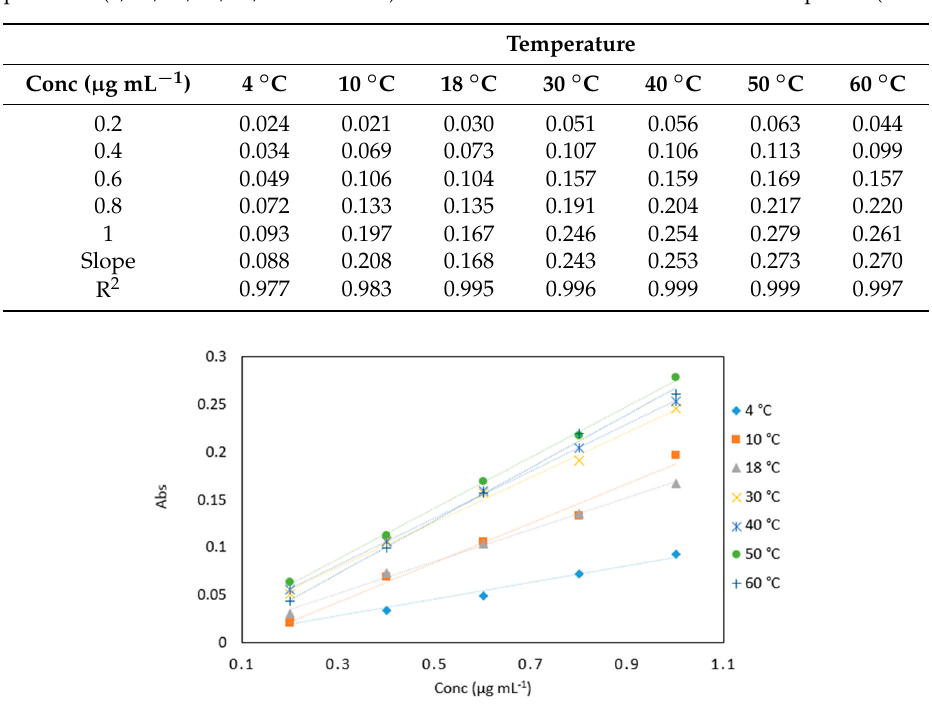
Figure 5. A comparison of arsenic samples (0.2–1 μ g mL − 1 ) analyzed at various incubation temperatures (4, 10, 18, 30, 40, 50 and 60 °C). All measurements were carried out in triplicate ( n = 105).